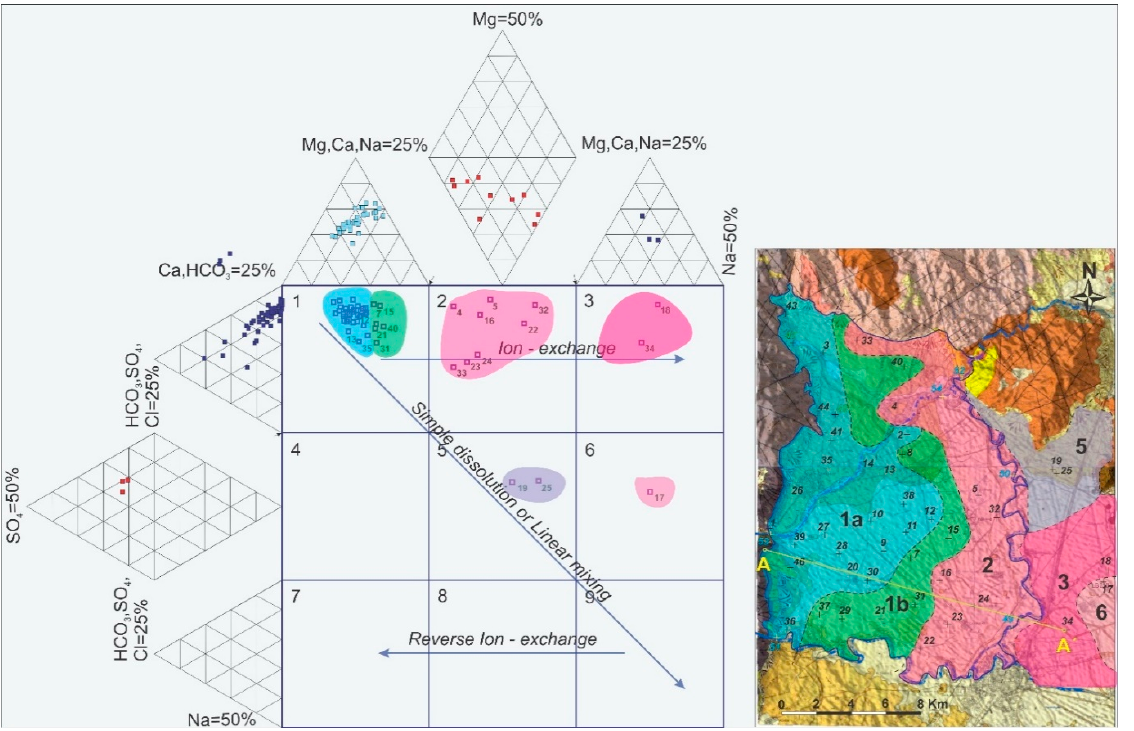
Figure 6. Expanded Durov plot illustrating the hydrogeochemical processes [36] and their spatial distribution in the study area.